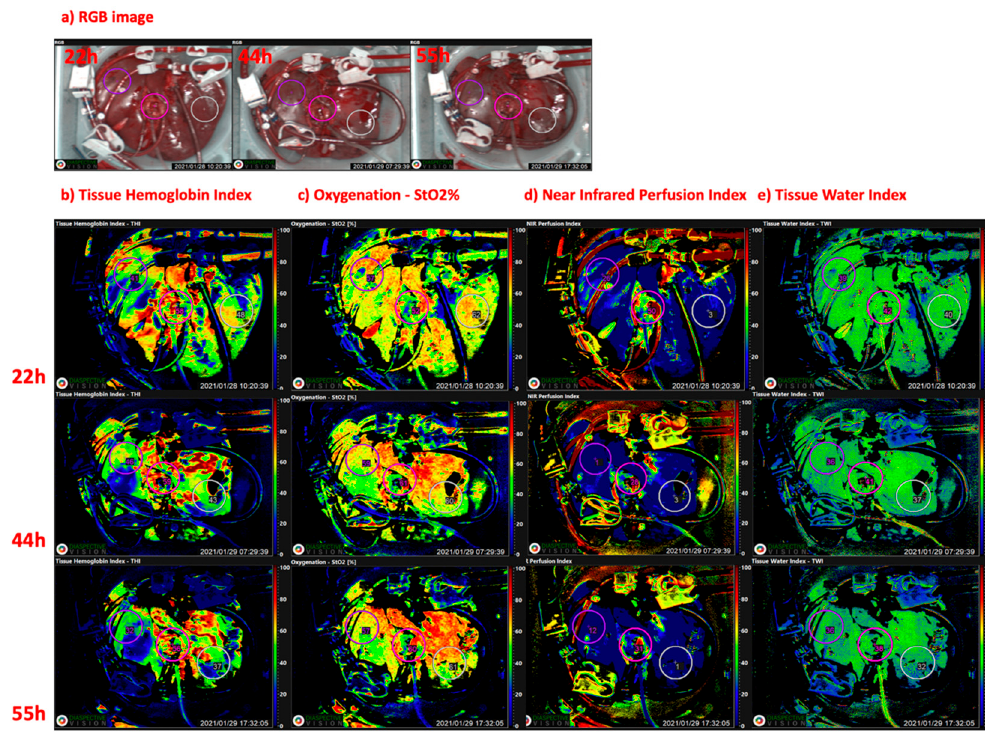
Figure 2. Hyperspectral imaging (HSI) applied on human livers after 22 h, 44 h, and 55 h NMP in an experimental setting; representative intraoperative ( a ) RBG image, corresponding HSI generated color coded, ( b ) tissue hemoglobin index (THI), ( c ) oxygen saturation index (StO2%), ( d ) near-infrared perfusion index (NIR), ( e ) tissue water index (TWI). Three standardized markers were placed on peripheral (right/left lobe) and central compartments. Intraoperative images were acquired using the TIVITA ® Tissue HSI system (Diaspective Vision, Germany). For undisturbed image acquisition and data generation, the ambient light in the operating room had to be dimmed. The camera system incorporates a high number of spectrally differentiated channels which acquires pictures with a high spectral resolution (5 nm) in the visible and near-infrared range (500–1000 nm). This scanner is mounted on a moving arm which is brought to the organ. Using a 25 mm focal lens, a constant distance of 50 cm between the object and camera has to be retained during image acquisition. The HSI camera subsequently takes an RGB picture and in parallel computes a pseudo-color image, which represents physiologic parameters such as oxygen saturation, near-infrared perfusion, tissue hemoglobin, and tissue water of the recorded area. The maximum relative penetration depth of this HSI system is 6 mm. Quantitative StO2% measurements can either be performed at a depth of up to 1 mm for superficial microcirculation evaluation as well as at a depth of 4–6 mm,, which corresponds to wavelengths recorded within the near-infrared spectrum. HSI can be applied almost “real time” and the acquisition for the hyperspectral image takes less than 10 s. All images are stored, and further analysis of the hyperspectral data can be performed on the system with the TIVITA ® Suite software. HSI: hyperspectral imaging; NMP: normothermic machine perfusion; RGB: red-green-blue image; THI: tissue hemoglobin index; StO2%: oxygen saturation index; NIR: near infrared perfusion index; TWI: tissue water index.